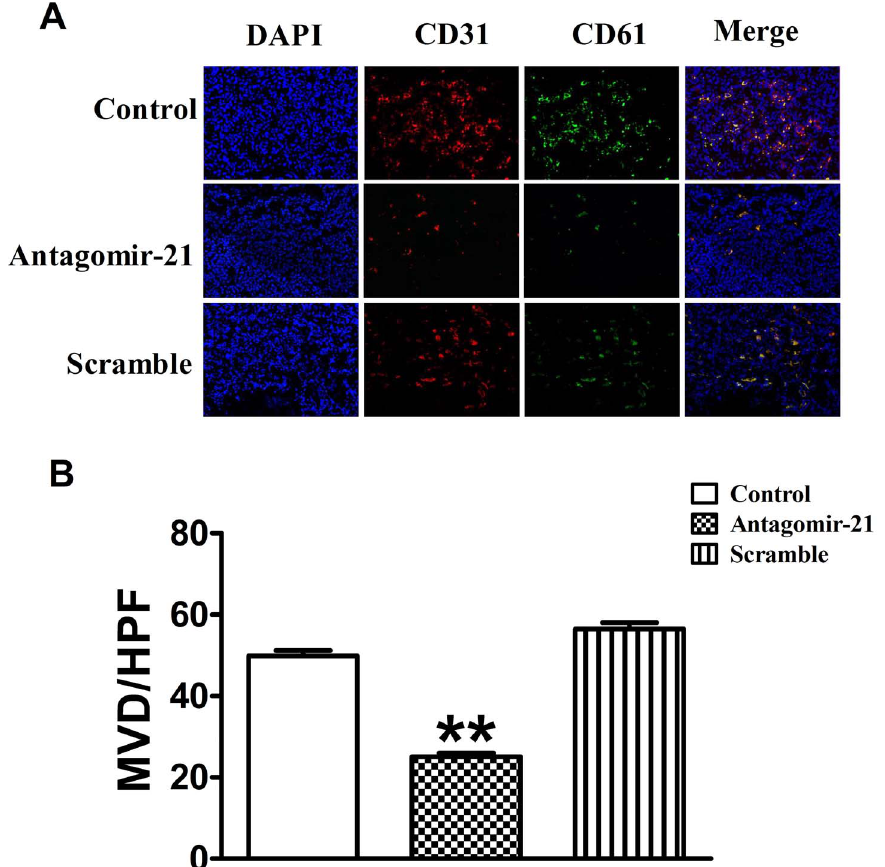
Figure 4. Knockdown of miR-21 expression inhibits angiogenesis of breast tumors. (A) Representative CD31 and CD61 immunostaining images were taken under different experimental conditions as indicated (Original magnification, 6 200). Red color is staining for CD31, green color is staining for CD61, and blue color is staining for cell nucleus. (B) MVD of breast tumor was determined by the vessel counts, which were stained with antibodies against both CD31 and CD61. MVD: microvessel density, HPF: high-power field. Data are expressed as mean 6 SEM. ** P , 0.01 vs control group.